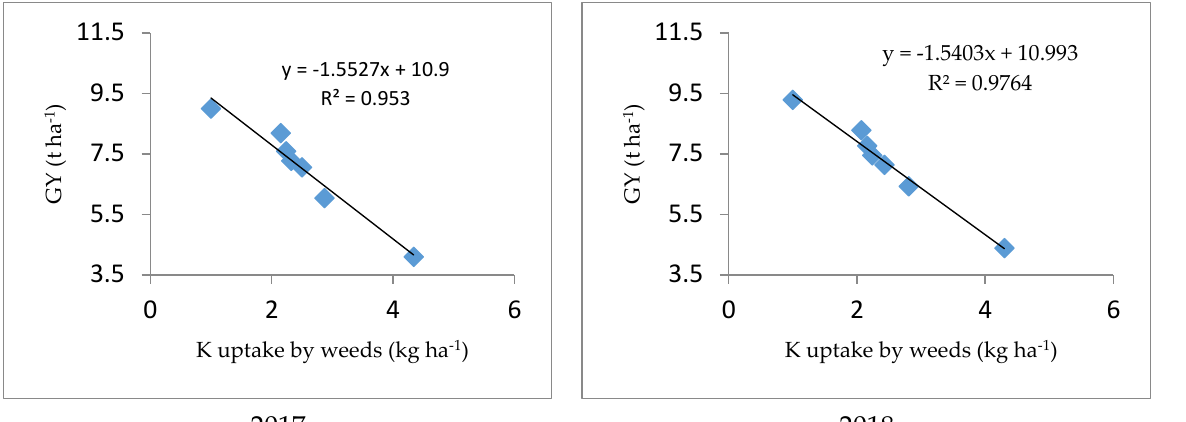
Figure 16. Linear regression line among weed control measures between K-uptake by weeds vs. Grain yield (GY).